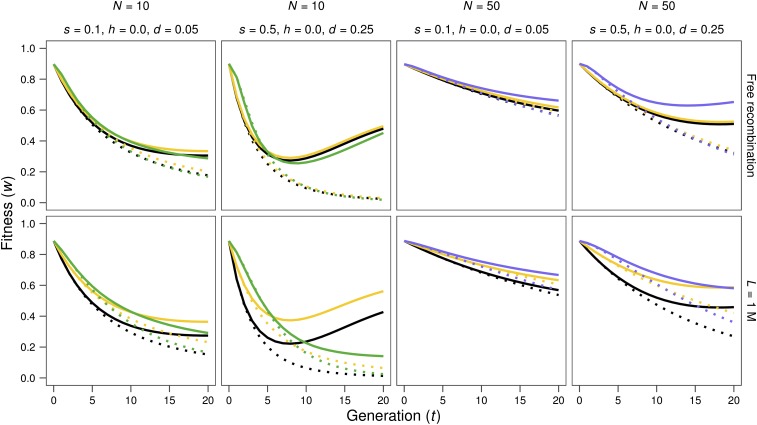
Short-term evolution of average fitness after a reduction of population size. Solid lines: MSD results and IP predictions. Dotted lines: MD results and neutral predictions. Green: average fitness obtained from simulation results for N = 10; blue: average fitness obtained from simulation results for N = 50; black: average fitness predicted using the inbreeding load of the base population (B); yellow: average fitness predicted using the realized estimate of the inbreeding depression rate δ (see text). Different panels represent different cases regarding d value [d = s(1/2 – h)] for h = 0, genome length (L, given in Morgans), and reduced census (N).